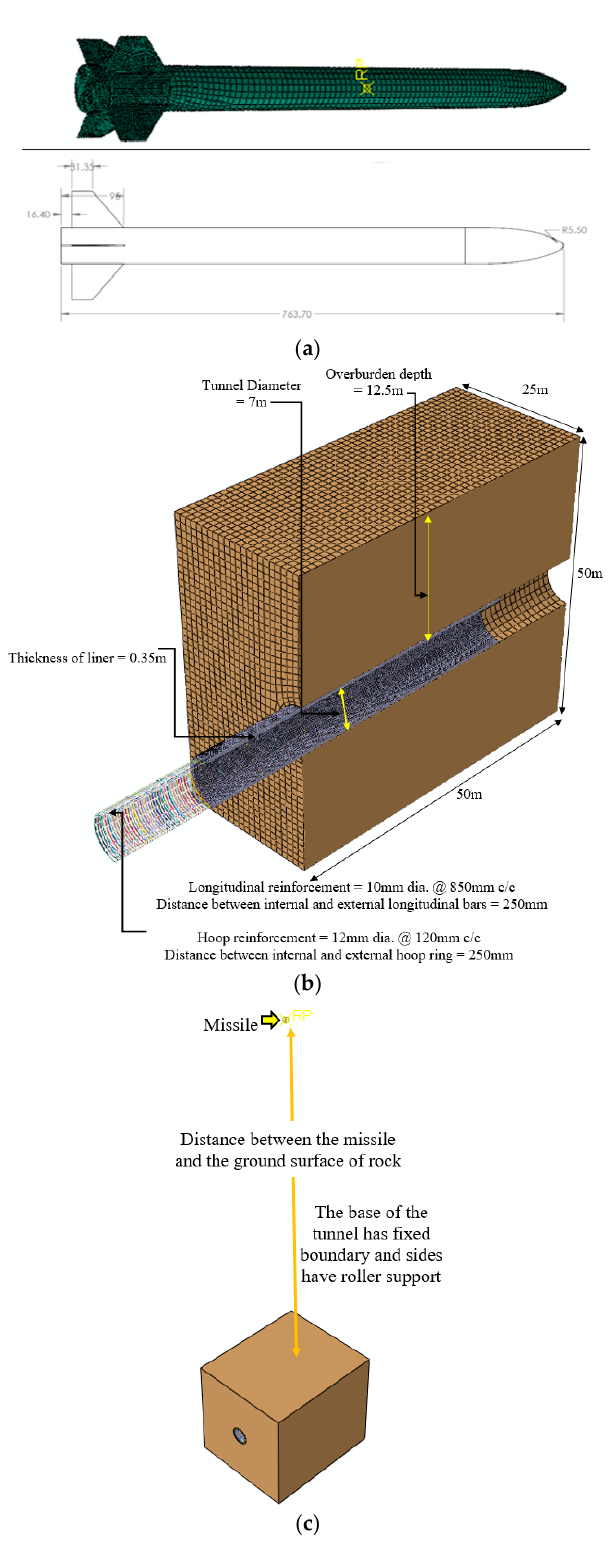
Figure 1. Geometry of finite element model for impact loading simulation. ( a ) Abaqus model of Missile, 0.7637 m in length and a mass of 100 kg with 5 Mach velocity ( b ) Tunnel with an opening of 7 m in diameter and supported by a reinforced concrete(M30) liner of 0.35 m in thickness. ( c ) The rock surrounding the tunnels of 50 m × 50 m × 50 m and 12.5 m of overburden